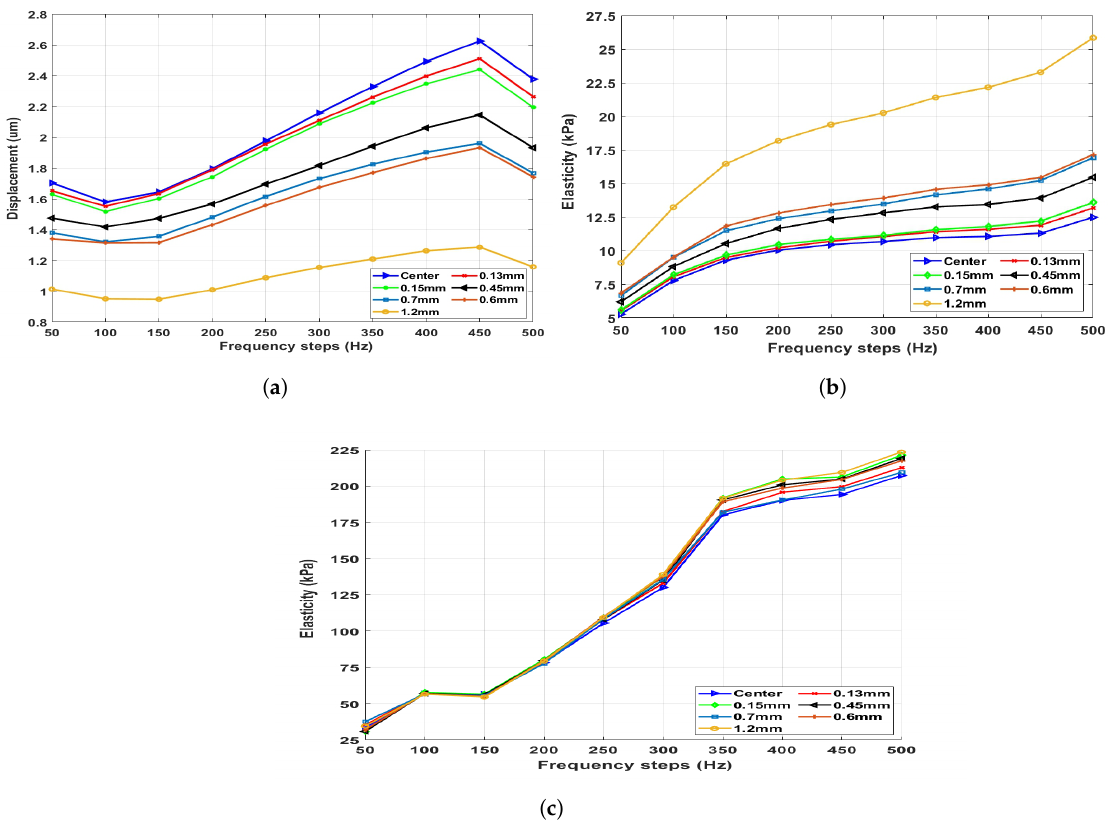
Figure 9. Measurements of the seven different laser spot locations; ( a ) measured displacement of the 1:1:2 mixture; ( b ) elastic modulus of the 1:1:2 mixture; ( c ) elastic modulus of the 1:1:0